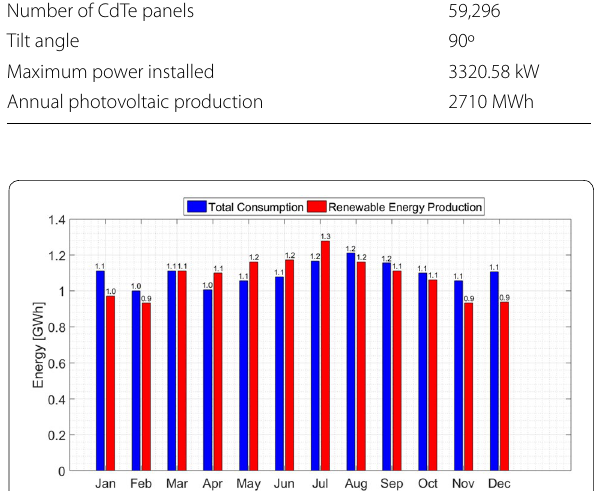
Fig. 11 Estimated total renewable energy emission and monthly consumption for 2018 in Graciosa